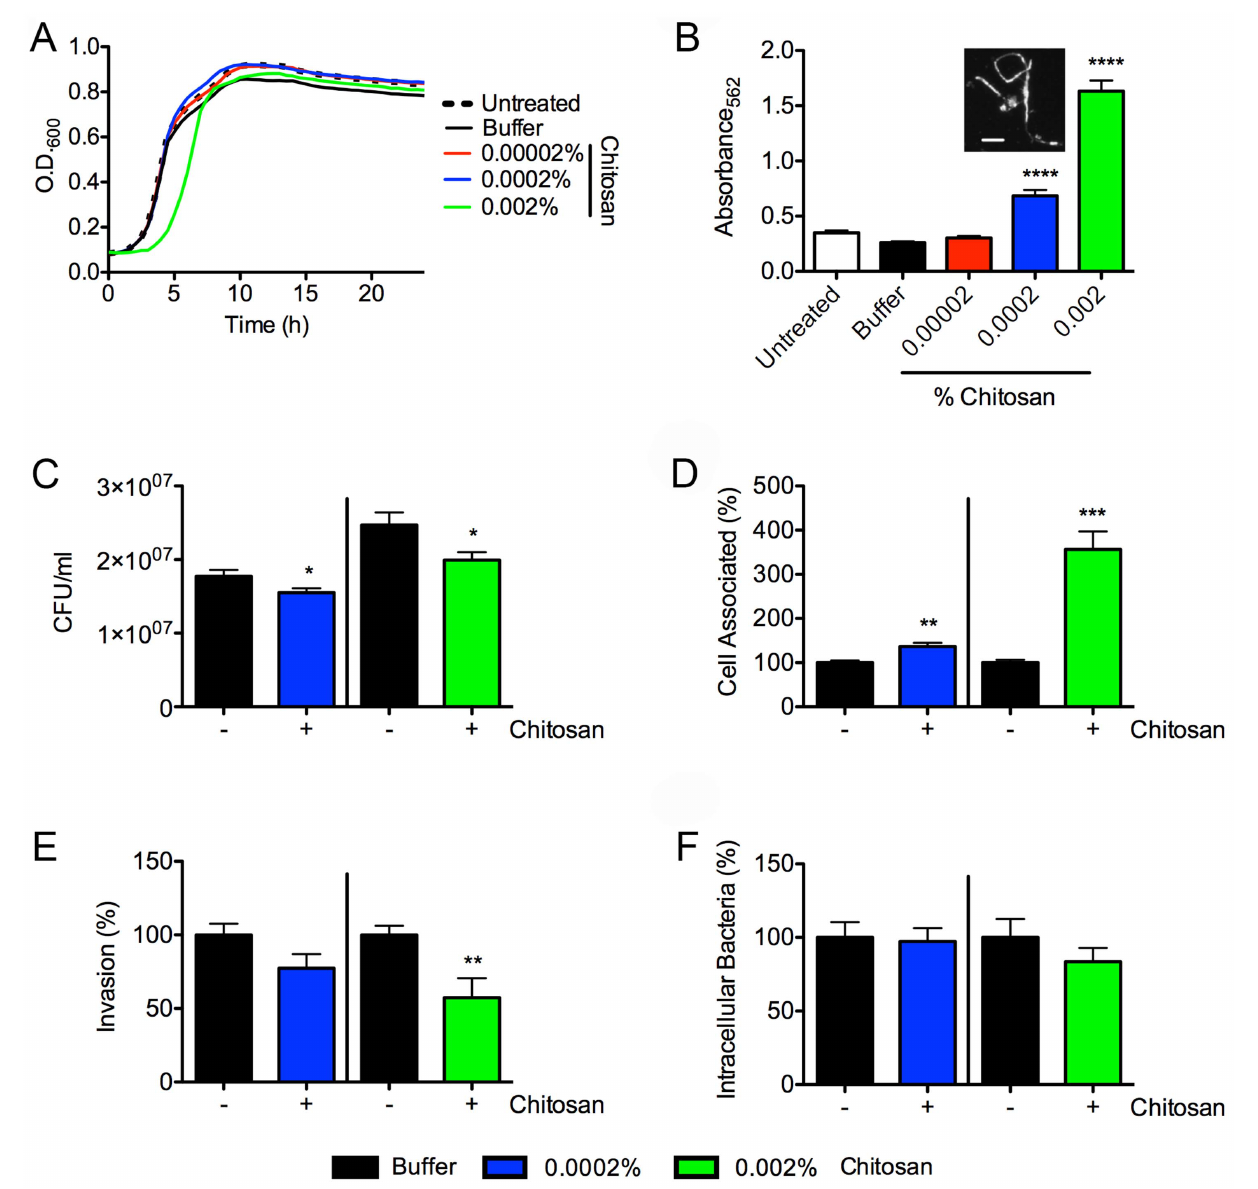
Figure 1. Chitosan affects UPEC growth, biofilm formation, and interactions with BECs. ( A ) Growth of UTI89 in modified M9 medium containing increasing concentrations of chitosan (0.00002, 0.0002, 0.002%) or phosphate buffer (pH 4.5). Data shown are representative of three independent experiments carried out in triplicate. ( B ) Graph shows chitosan effects on biofilm production by UTI89 relative to untreated controls, as measured by microtiter plate assays. Data represent mean results 6 SEM from three separate experiments performed in quadruplicate. Inset shows an example of filamentous bacteria in 0.002% chitosan; scale bar, 10 m m. Chitosan (0.0002 or 0.002%) effects on ( C ) UTI89 growth in RPMI medium during a 2-h incubation with 5637 BECs, ( D ) bacterial attachment to BECs, ( E ) bacterial invasion of BECs, and ( F ) bacterial survival within BECs over a 14-h period were quantified relative to buffer-treated controls. The data in F were normalized by dividing the numbers of surviving intracellular bacteria recovered from BECs after the 14-h incubation with gentamicin by the numbers of invading bacteria present after the 2-h incubation with gentamicin. Graphs show mean results 6 SEM from three independent experiments performed in triplicate. * P , 0.05, ** P , 0.01, *** P , 0.001 versus buffer-treated controls, as determined by Student’s t test with Welch’s correction when